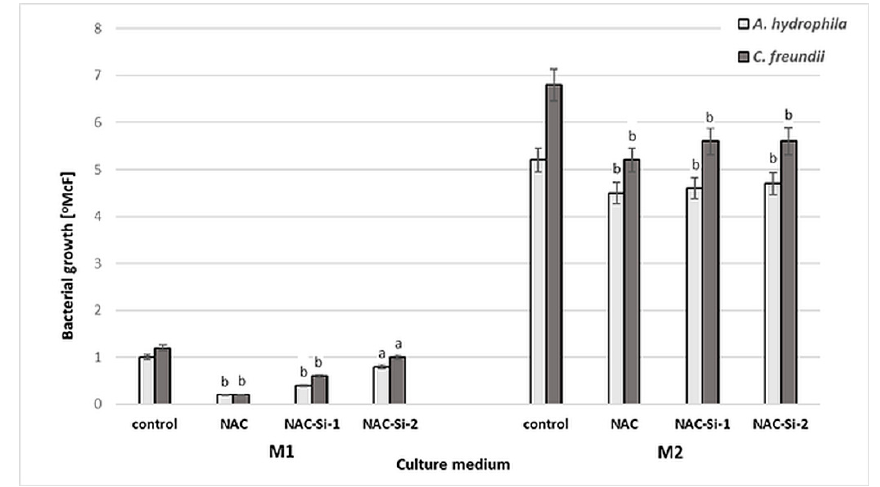
Figure 4. Growth [°McF] of bacterial strains in minimal M1 and enriched M2 culture media in the presence of NAC and its derivatives NAC-Si-1 and NAC-Si-2 in comparison to that in control samples (without NAC and its polymer derivatives). Values show the mean ± standard deviation (SD, n = 3). Values with different letters are statistically different: a, p ≥ 0.05; b, 0.005 < p < 0.05.